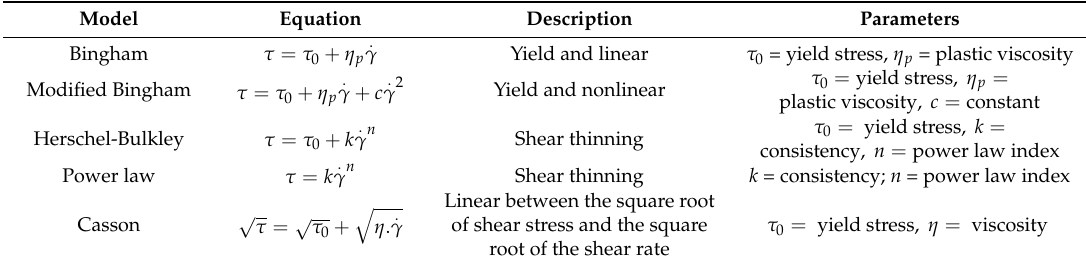
Table 1. Rheological models used for describing the flow curve of injection grouts.